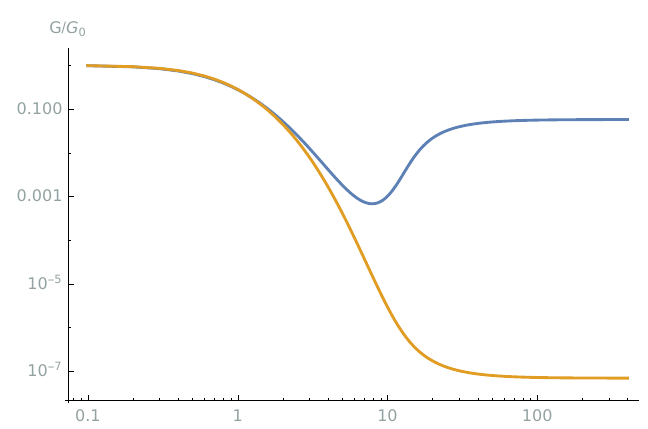
Figure 18 . The two-point function including the extrinsic curvature term (yellow) compared to the two-point function as exponentiated geodesic (blue). The long-time value of the two-point function is (cid:24) exp( (cid:0) N